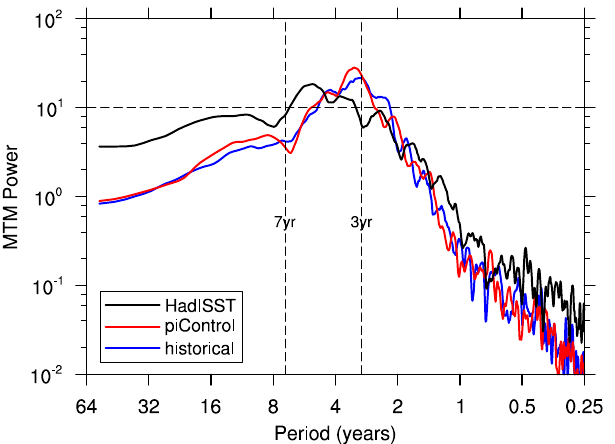
Figure 20. Time series of Southern Oscillation index (5 month run- ning mean) from 1951 to 2005. The observed SOI is calculated us- ing station data from Darwin and Tahiti. Absolute, rather than nor- malized, time series are used